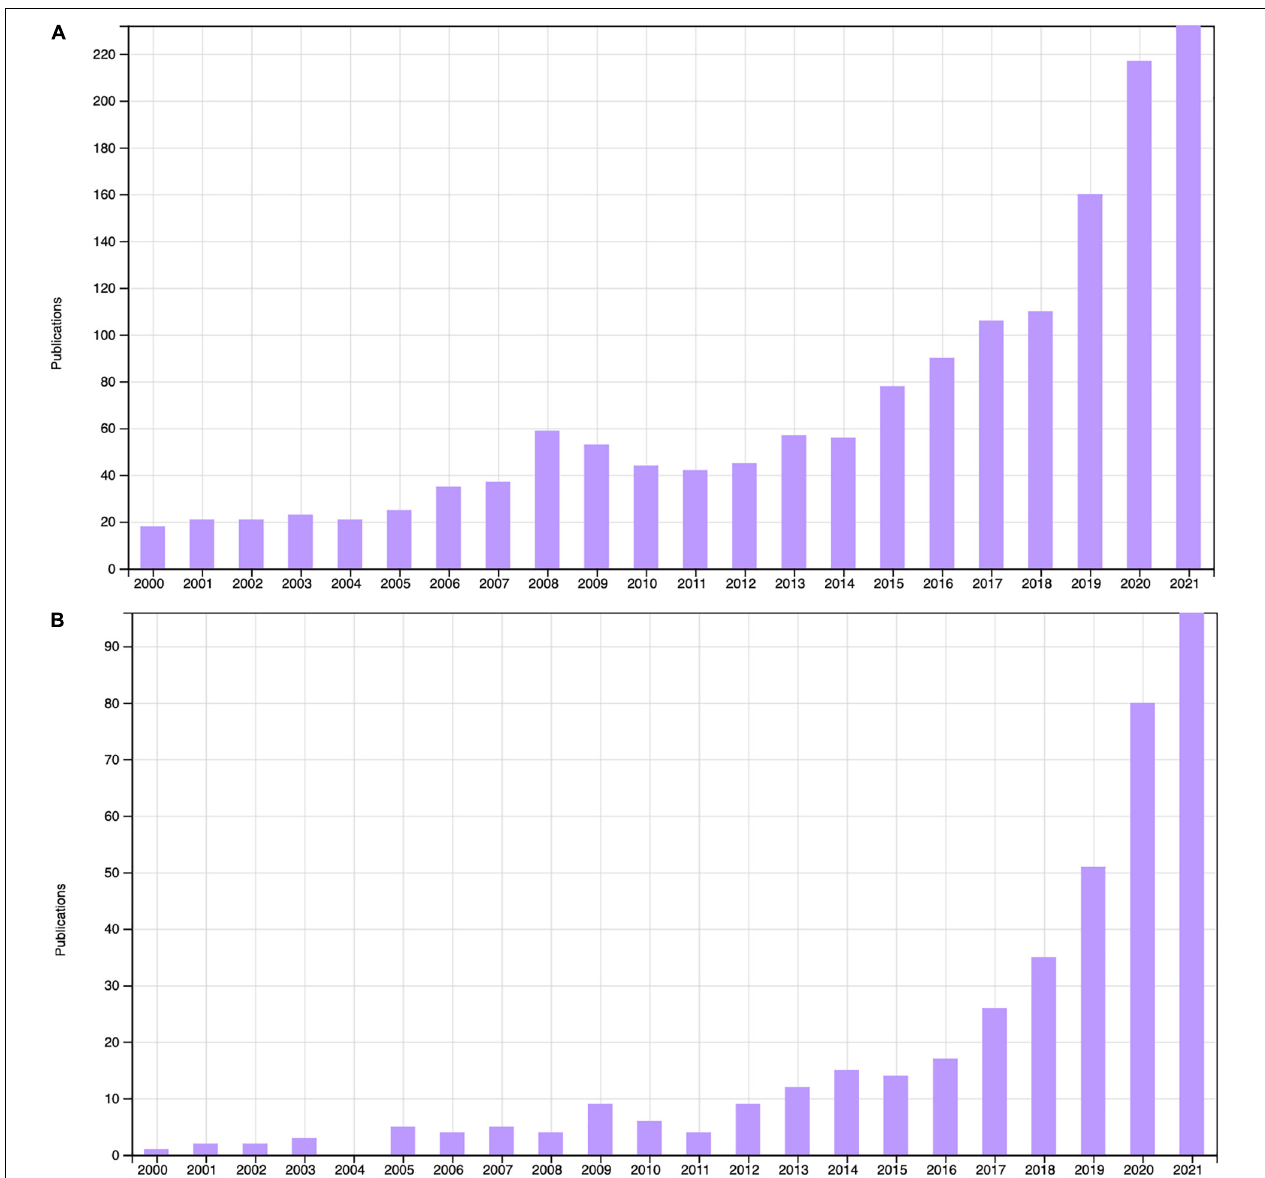
FIGURE 1 | Peer-reviewed articles with “Ketogenic diet” in the title or abstract (A) and “Intermittent fasting” in the title or abstract (B) 2000–2021, Web of Science (accessed 16/12/2021).